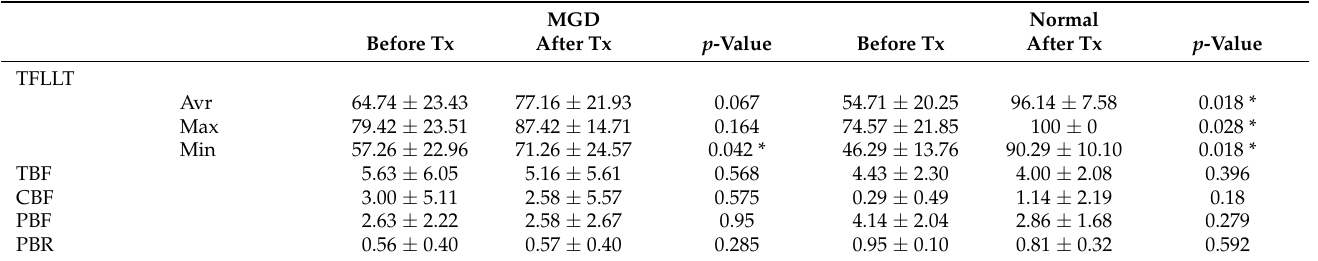
Table 3. Comparison of tear film lipid layer thickness and interferometer-derived parameters before and after treatment. (Differential analysis for MGD and normal groups).